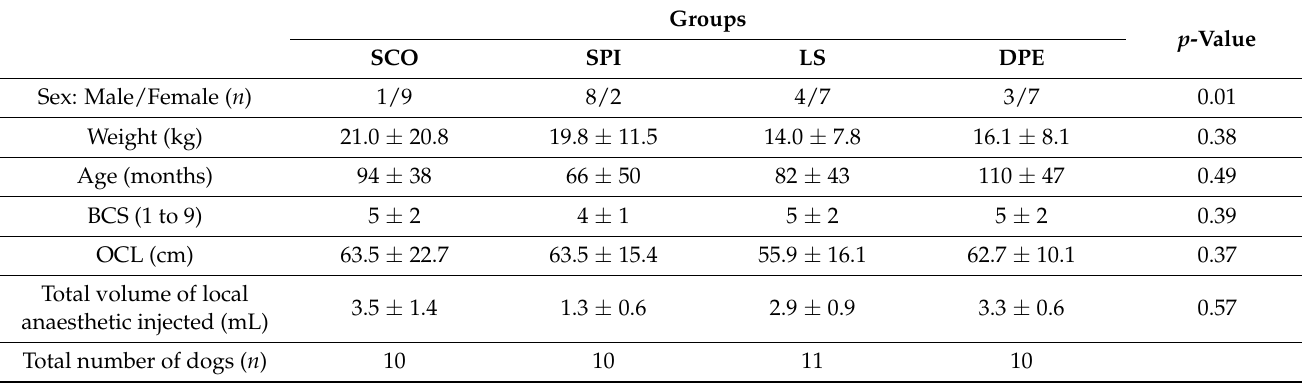
Table 2. Sex distribution and mean ± SD of weight, age, body condition score (BCS), occipital-coccygeal length (OCL), total volume of local anaesthetic injected in the neuraxial technique, and the number of dogs per group. SCO, epidural injection in the sacrococcygeal space; SPI, injection in the subarachnoid space; LS, epidural injection in the lumbosacral space; DPE, dural puncture epidural injection.